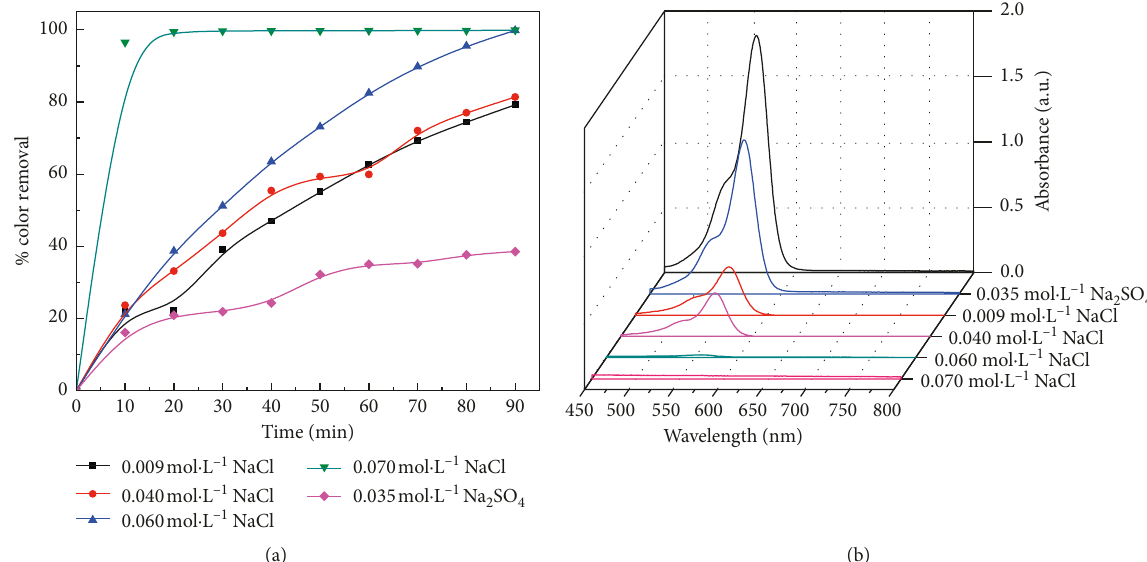
Figure 3: Effect of NaCl and Na 2 SO 4 and their concentration on the dye removal. (a) Color removal efficiency versus time and (b) their corresponding visible spectra after 90min of electrolysis. Conditions: current density, 5.4mA · cm − 2 ; [Rh-B], 80mg · L − 1 ; T , 25 ° C; flow rate: 30L · h − 1 .